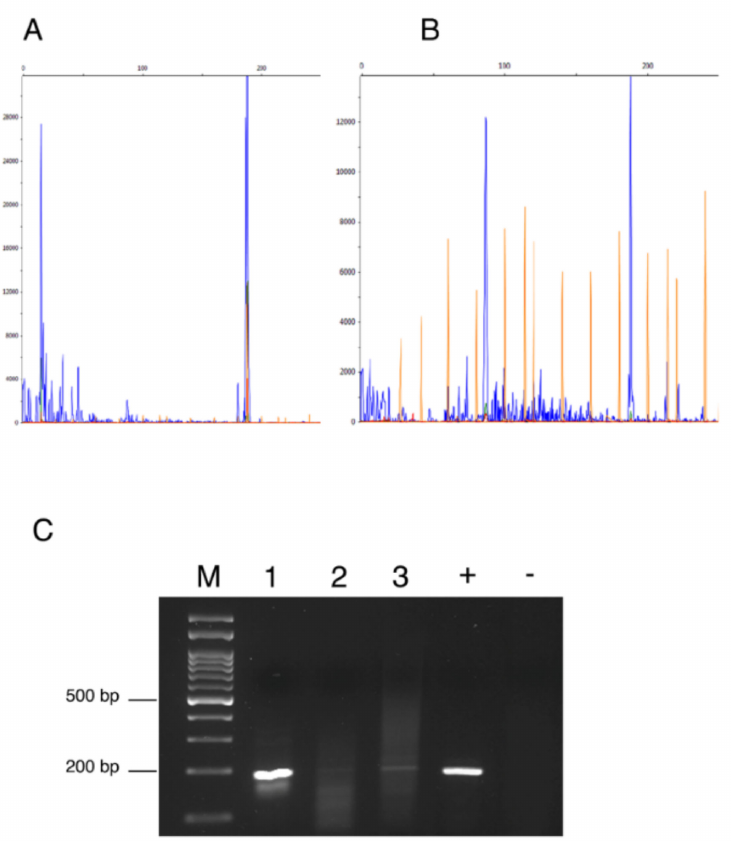
Figure 1. Fragment analyses showed the blue peaks at 191 bp representing the size of the amplified env fragment in sample ID #28983 ( A ) and sample ID #873/03 ( B ). ( C ) The 2% Agarose gel elec- trophoresis of PCR products with target size of 191 bp. (M): molecular weight marker; (1): ID #28983; (2): ID #259; (3): ID #873/08; (+) positive control; ( − ) negative